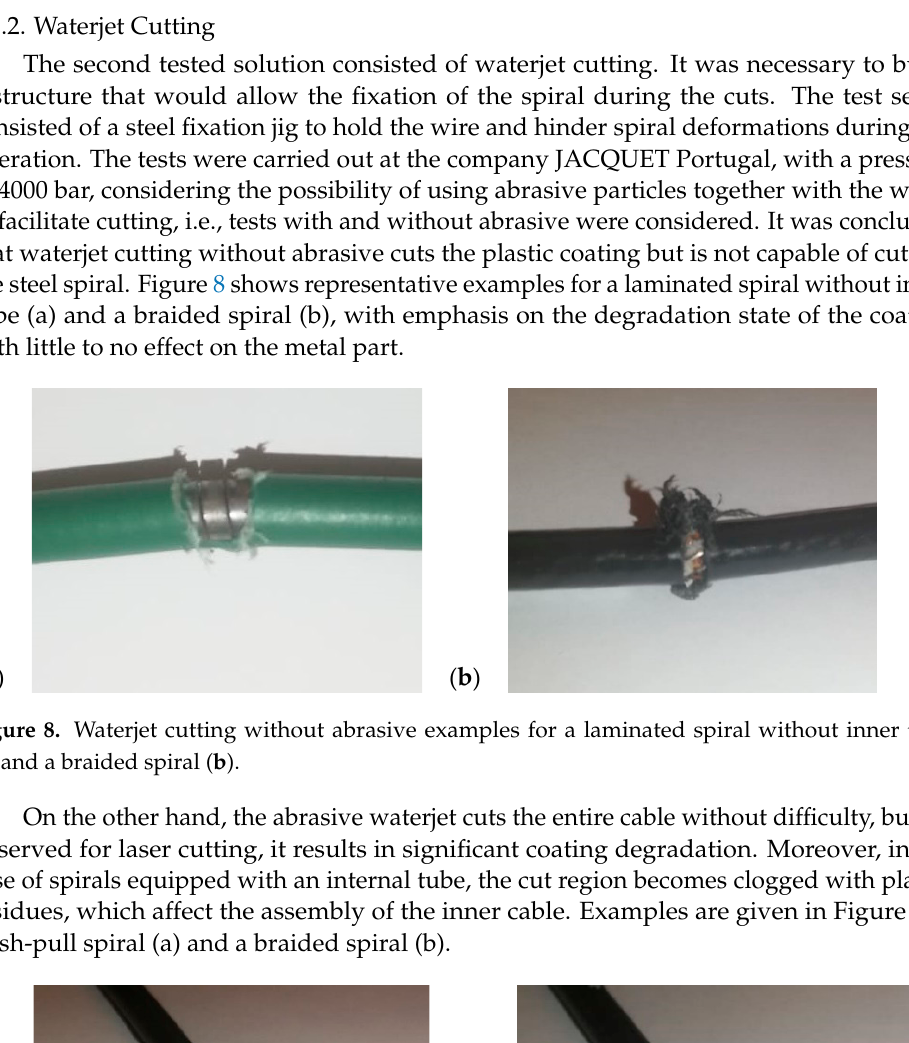
Figure 7. Laser cutting test results for the laminated spiral without inner tube.